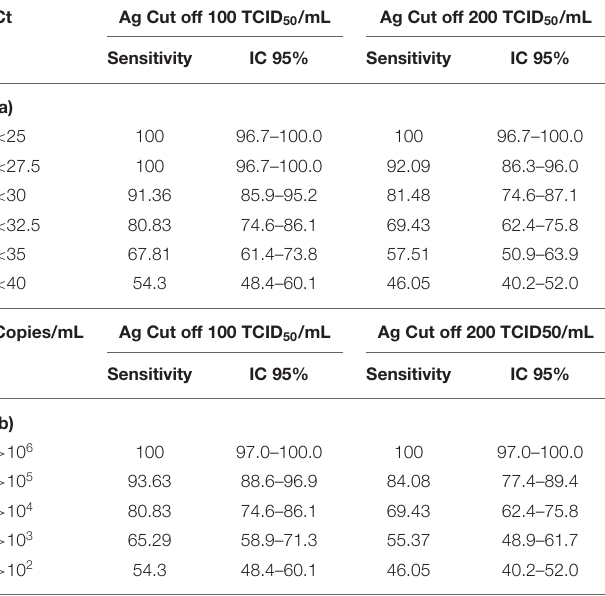
TABLE 3 | Antigen determination sensitivity according to both TCID 50 /ml cutoff adjusted for (a) different Ct and (b) extrapolated